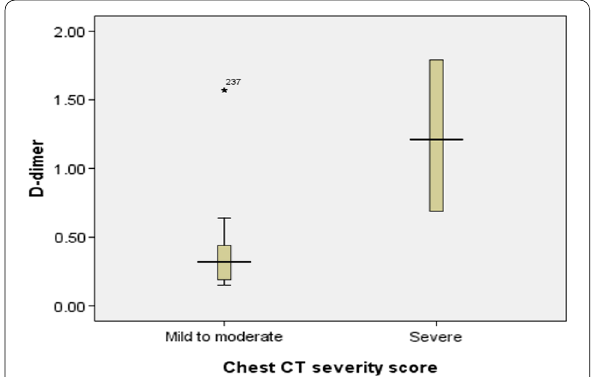
Fig. 5 Box‑plot analysis of D‑dimer in relation to grading of CT severity score